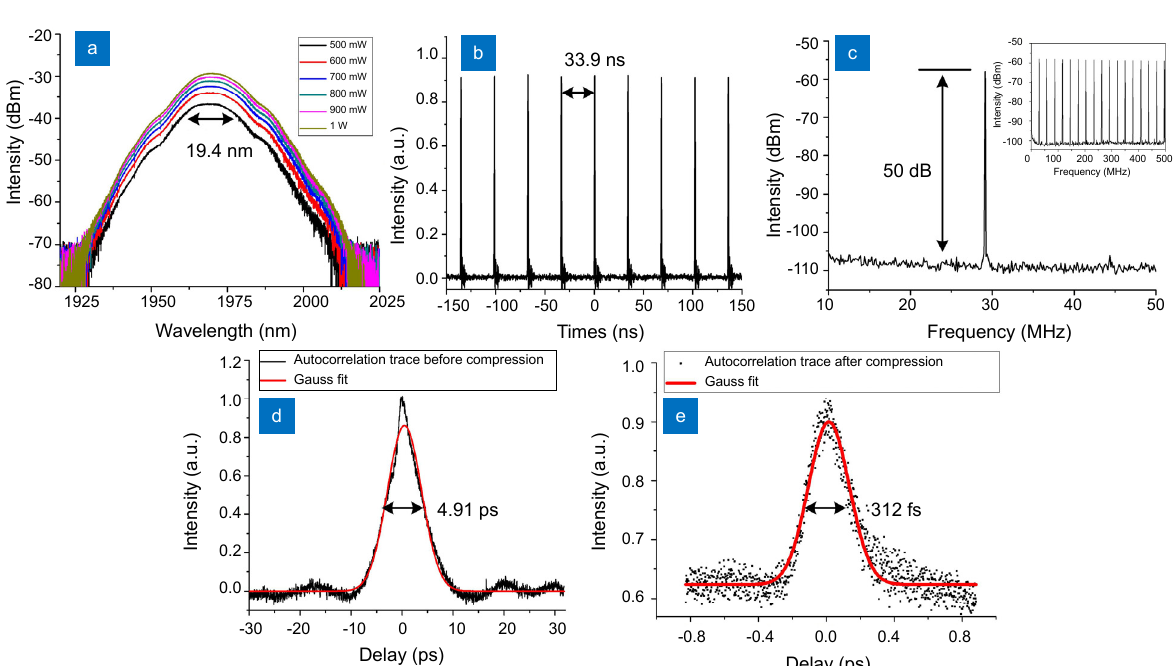
Fig. 3 | Gaussian-type stretched pulses at -0.077 ps 2 net dispersion . ( a ) Gaussian-type spectra. ( b ) Pulse train. ( c ) Radio frequency spectra. ( d ) Autocorrelation trace before compression. ( e ) Autocorrelation trace after